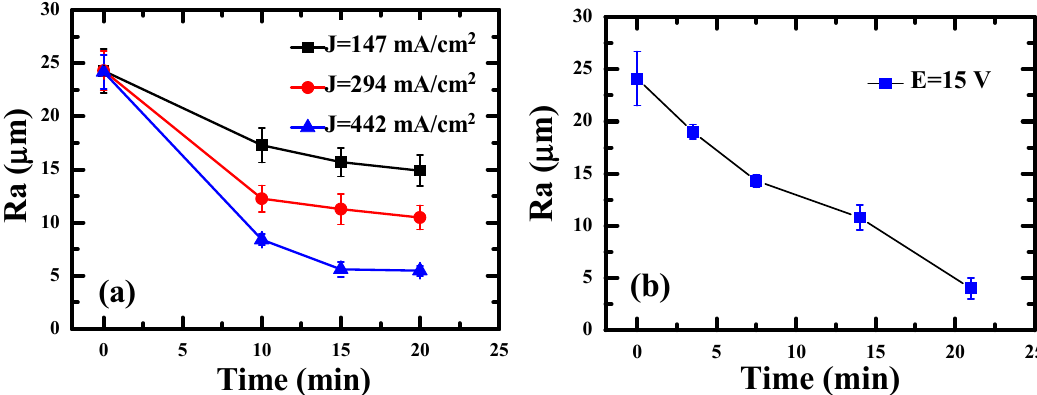
Figure 5. Variation of surface roughness Ra as a function of EP time: ( a ) under a constant current density of 147, 294, and 442 mA/cm 2 , respectively, and ( b ) under a constant voltage of 15 V. Table 1. Summary of physical properties of unpolished, polished 1, polished 2, and polished 3 tensile specimens. The polished 1, polished 2, and polished 3 samples are electropolished at a constant current density of 147, 294, and 442 mA/cm 2 , at 4 °C for 20 min.